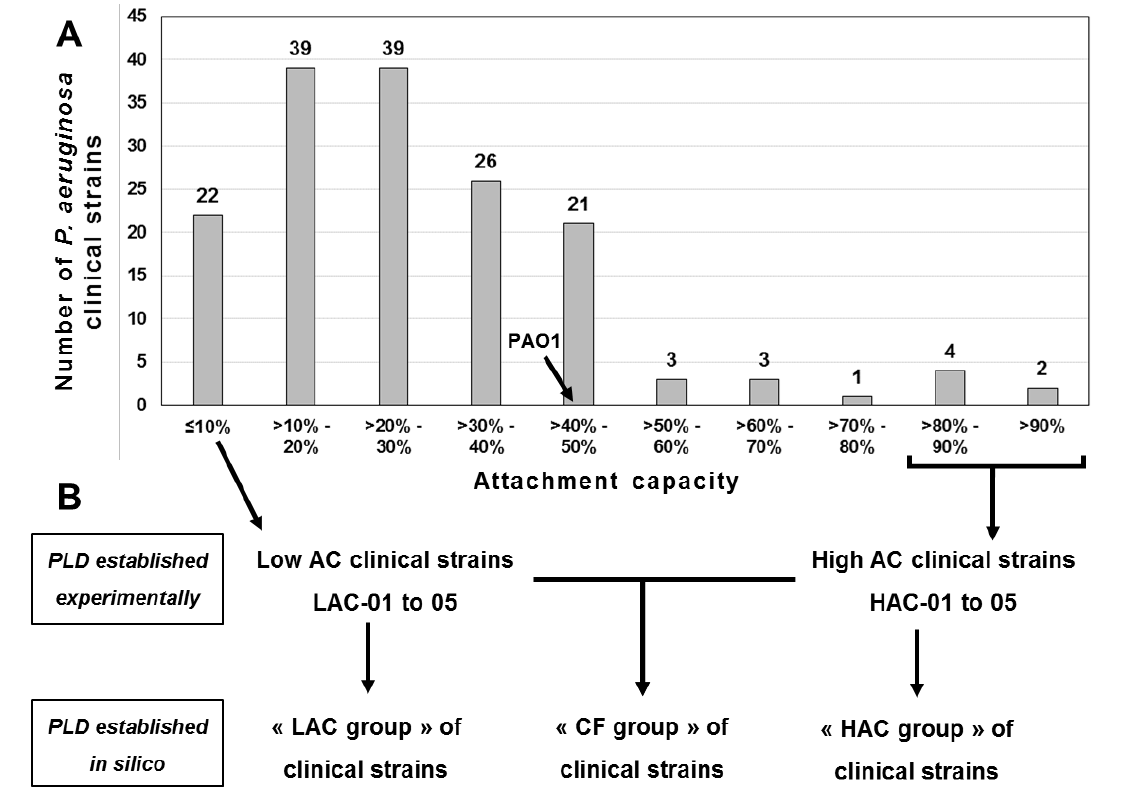
Figure 1. Attachment capacities of a collection and clinical Pseudomonas aeruginosa strains. ( A ) The attachment capacity ( AC ) of each P. aeruginosa strain was determined using a system initially developed to study the attachment phase, the first step in biofilm formation [14]. This system uses glass wool fibers as a colonization surface (see the Material and Methods section). We defined the AC as the proportion of bacterial cells from an inoculum that adhered to the glass wool fibers after 20 min of incubation. This value is expressed as a percentage and is rounded to the nearest unit. The phospholipidomes (PLDs) of P. aeruginosa PAO1, a collection strain, and of 10 cystic fibrosis ( CF ) clinical strains, were obtained from octuplates ( n = 8) of each strain. ( B ) The CF strains selected for this study comprised the five isolates exhibiting the lowest attachment capacities ( LAC-01 to -05 ) and the five isolates with the highest attachment capacities ( HAC-01 to -05 ). In silico PLDs were determined from experimental data obtained for all CF strains ( CF group ), LAC strains ( LAC group ) or HAC strains ( HAC group ).